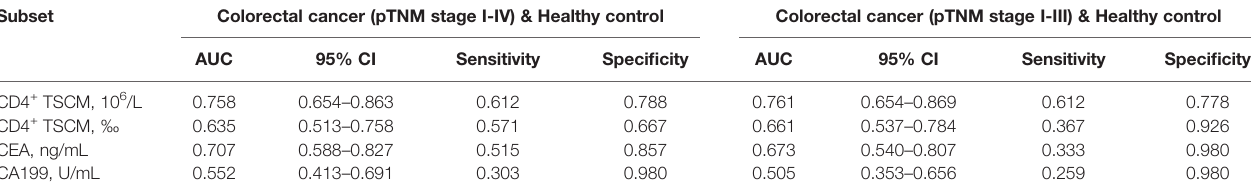
TABLE 3 | Receiver operating characteristic curve analysis to evaluate the use of CD4 + TSCM, CEA, and CA199 in early screening and auxiliary diagnosis of colorectal cancer.